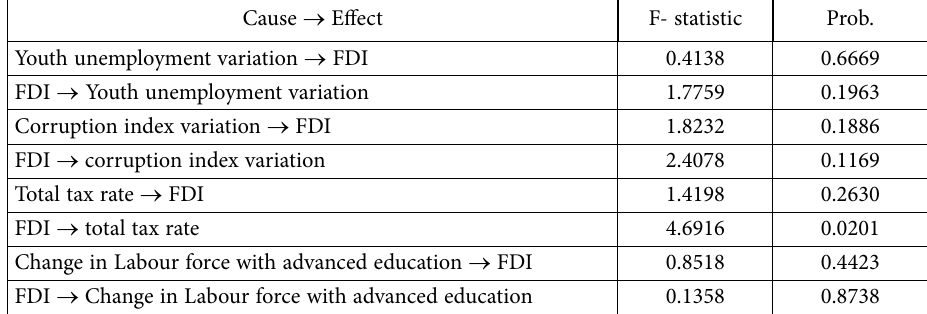
Table 11. Granger causality test for FDI and other variables in Poland, Czech Republic and Slovakia (2005–2016) (source: own results)